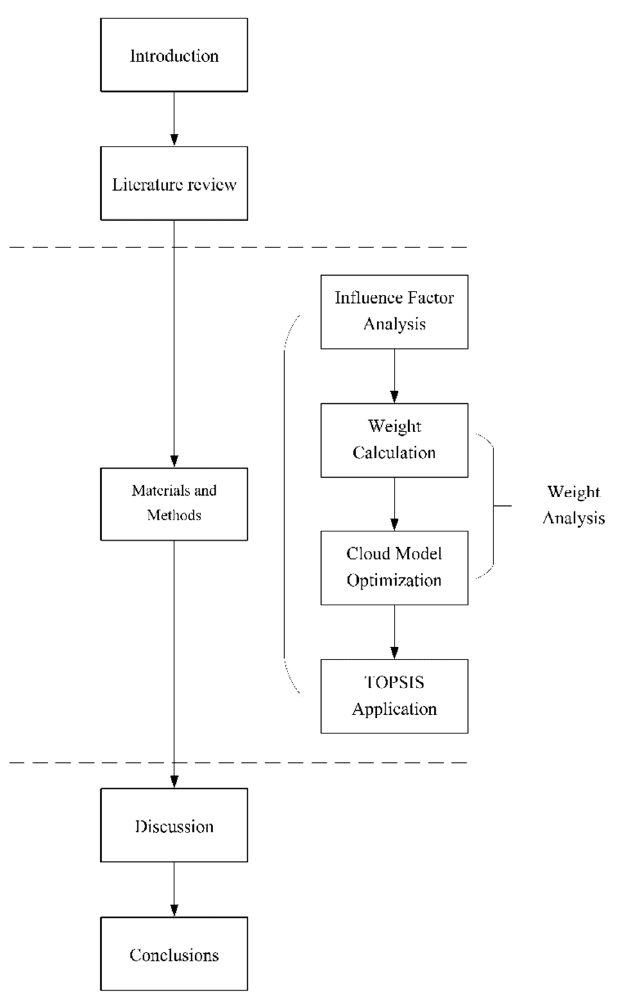
Figure 1. Research route.